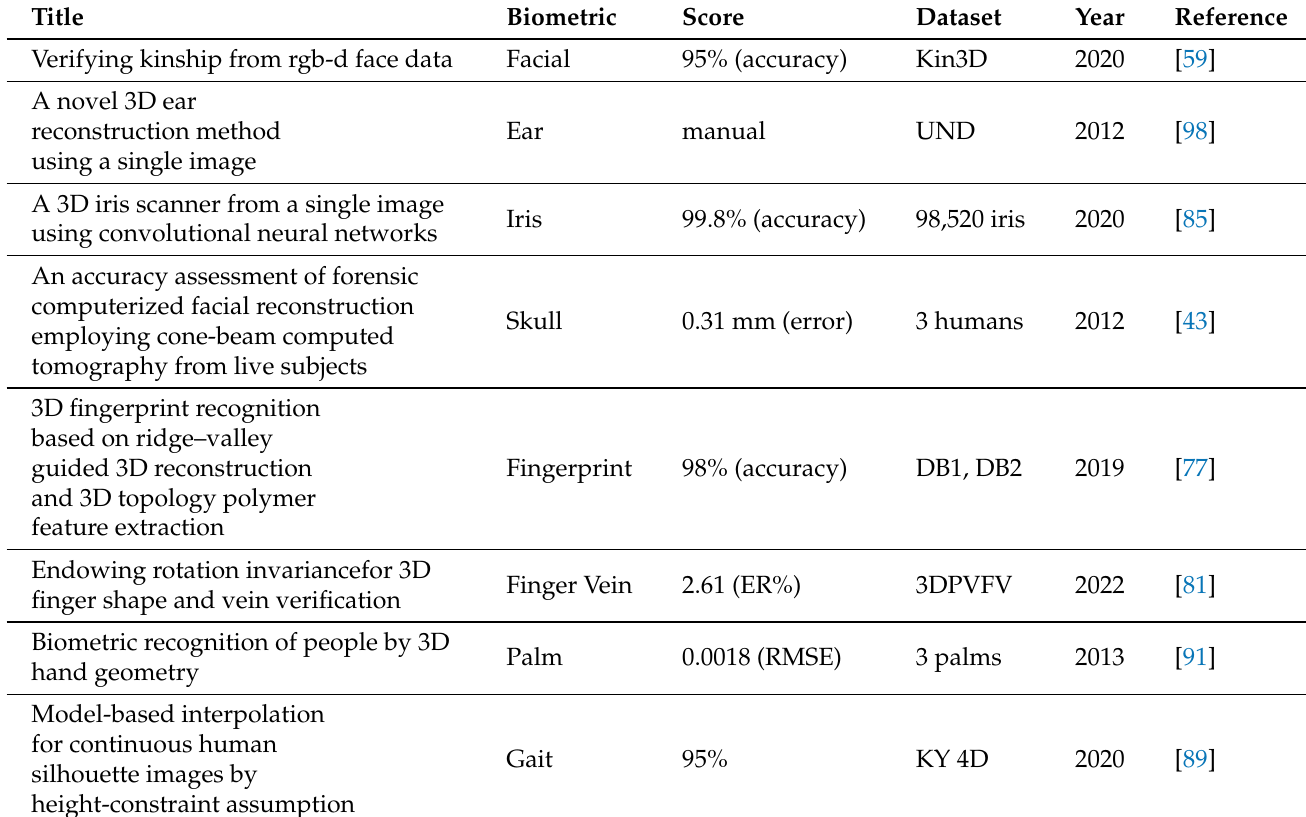
Table 3. Three-Dimensional (3D) Biometrics State of the